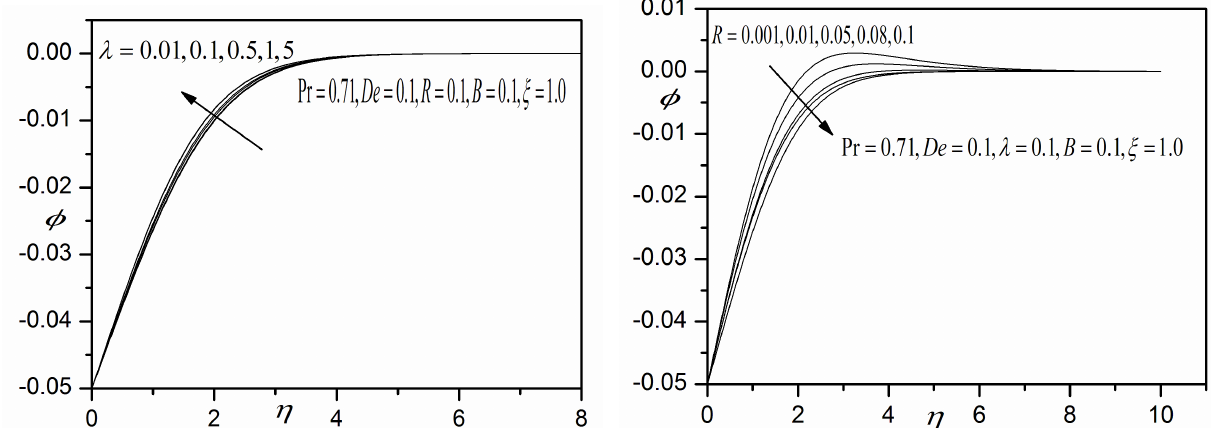
Fig. 6: Influence of λ on the temperature.